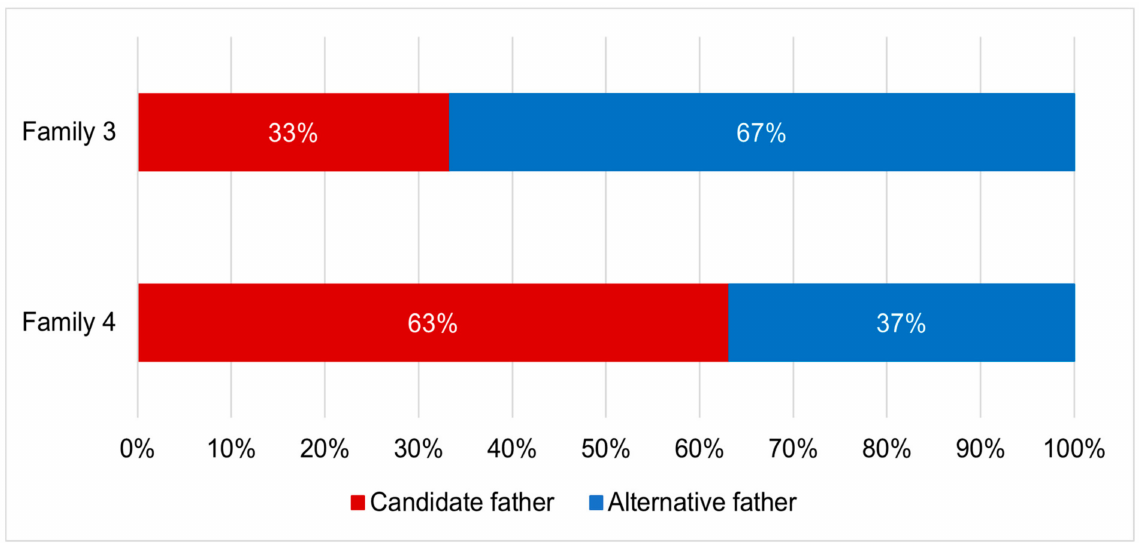
Figure 5. Relative contributions of both the candidate father and alternative father to the offspring in each of two Hermetia illucens families displaying multiple paternity, based on the genotypic exclusion method.